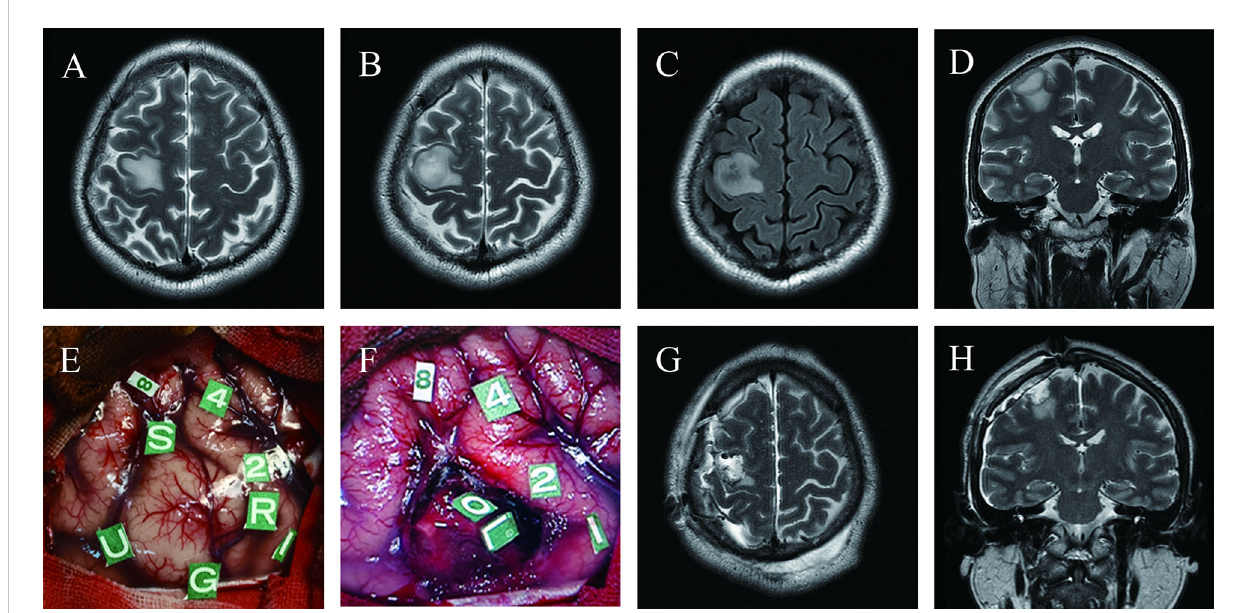
FIGURE 3 Maximum safe resection of astrocytoma with IDH mutation (WHO Grade 3) in the hand knob of the right precentral gyrus under awake craniotomy in a 38-year-old man presenting with seizures (Case 11); Pre-operative T2 axial (A, B) , T2 FLAIR axial (C) and T2 coronal (D) MRI revealed the tumor ’ s location precisely on the hand knob of the right precentral gyrus; (E) Intraoperative view before tumor resection; Tumor borders marked with letter tags (Tag U, anterior; G, superior; S, inferior; R, posterior). Number tags show positive points of DES mapping (8, changes in vocal tone; 1, 2, 4, primary sensory cortex, paresthesia of the left forearm, palm, and thumb, respectively); (F) Intraoperative view subsequent to tumor removal; Tag L, subcortical area for wrist movement; O, subcortical area for fi nger movement; Postoperative axial (G) and coronal (H) T2-weighted MRI demonstrated total tumor